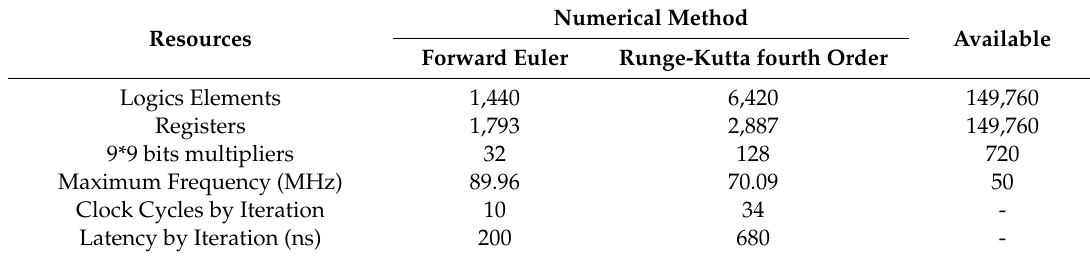
Table 2. Resources using the FPGA Cyclone IV EP4CGX150DF31C7 for implementing System (2) applying Forward-Euler and fourth-order Runge-Kutta methods.